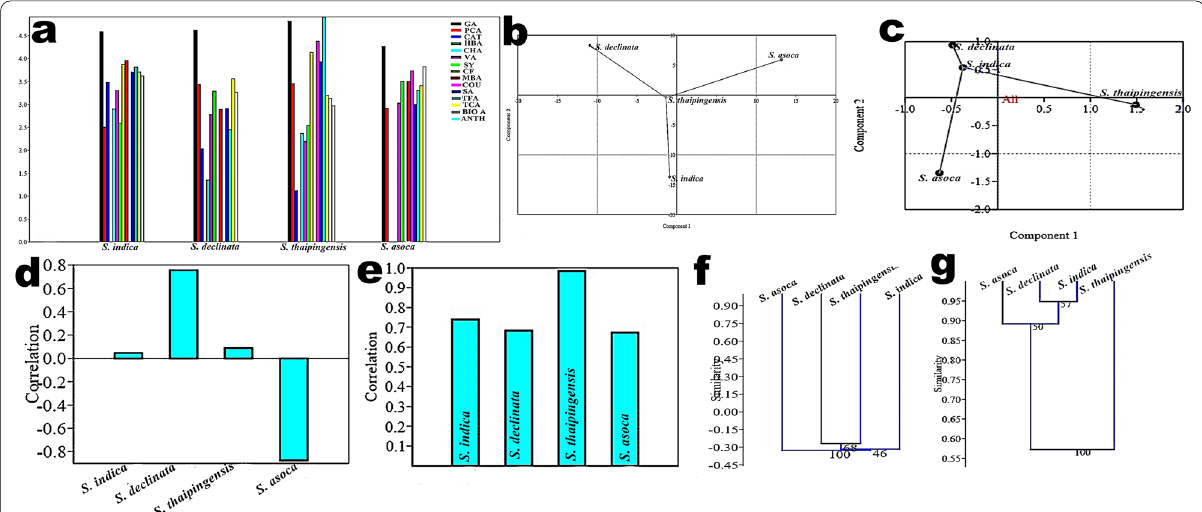
Fig. 6 Statistical analysis of biochemical data among four species of Saraca a Bar graph showing quantitative and qualitative phytochemical differences, b PCA scatter plot obtained from complete phytochemical data, c PCA scatter plot obtained by applying phytochemical data based on specific studied standards, d PCA loading plot obtained by using complete phytochemical data, e PCA loading plot obtained by using phytochemical data based on known standards, f Dendrogram obtained with UPGMA analysis applying complete phytochemical data and g Dendrogram obtained applying known phytochemical data based on known